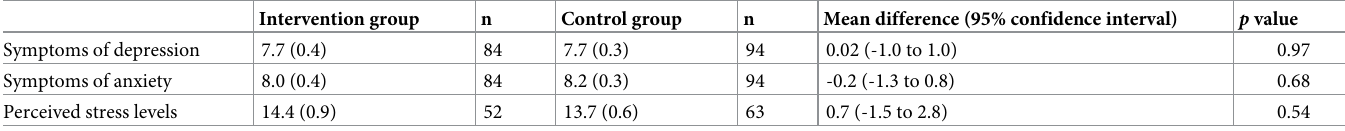
Table 3. Symptoms of depression and anxiety measured by the HADS and perceived stress measured by the PSS five years after lifestyle intervention according to allocation status.